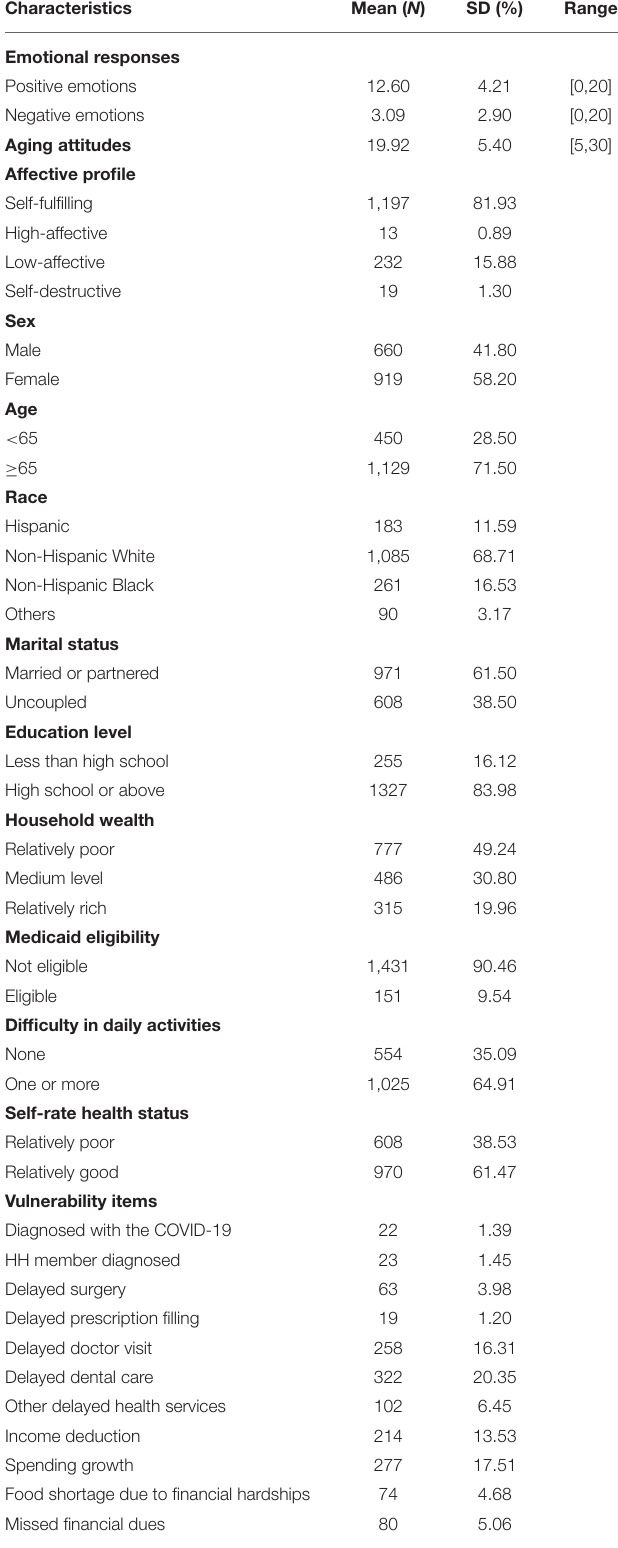
TABLE 1 | Descriptive analysis of the sample ( N = 1,582).